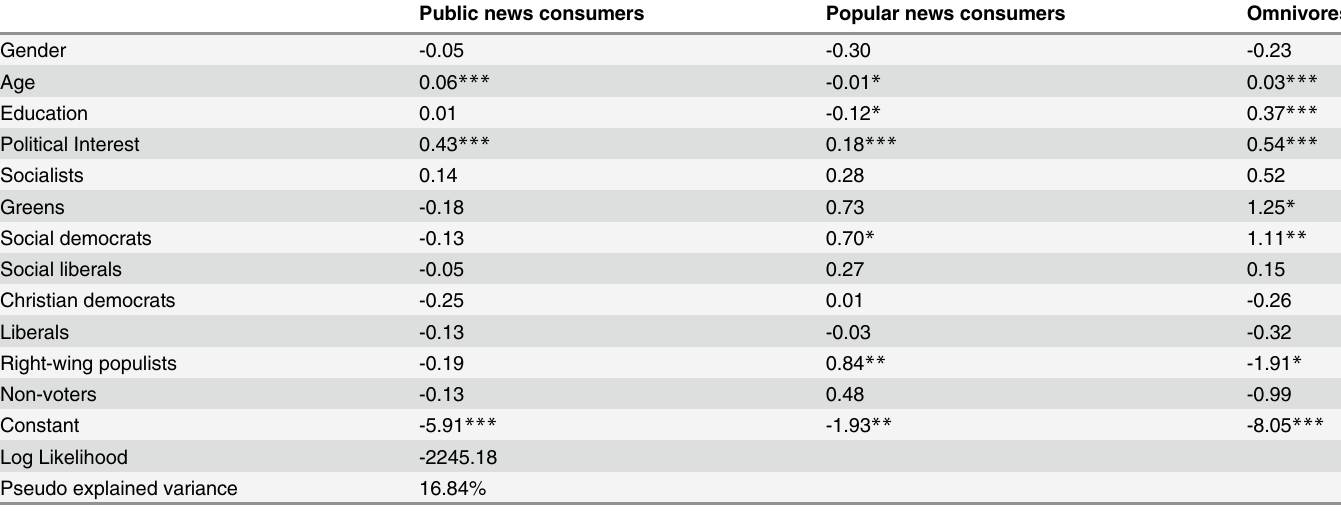
Table 3. Predictors of media profiles, multinomial regression analysis with minimalists as reference category (unstandardized regression